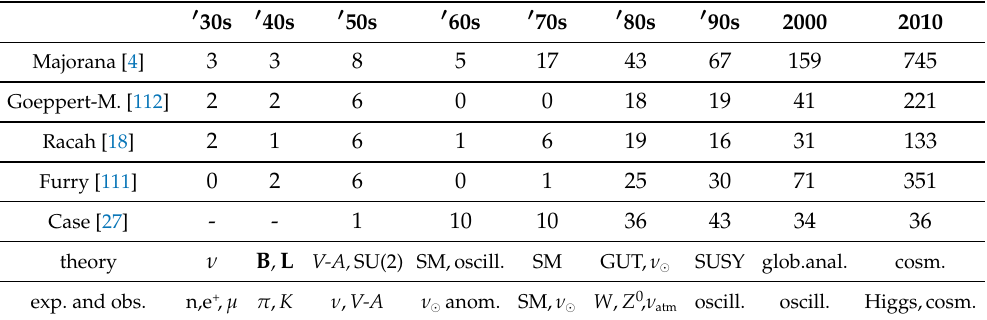
Table 2. The number of papers per decade citing a few seminal articles, including Majorana’s, from their appearance to the present day. In the last two lines, a (incomplete) list of theoretical and observational facts that are of major relevance for current discussion. From https://inspirehep.net/ (accessed on December 2020). GUT, grand unified